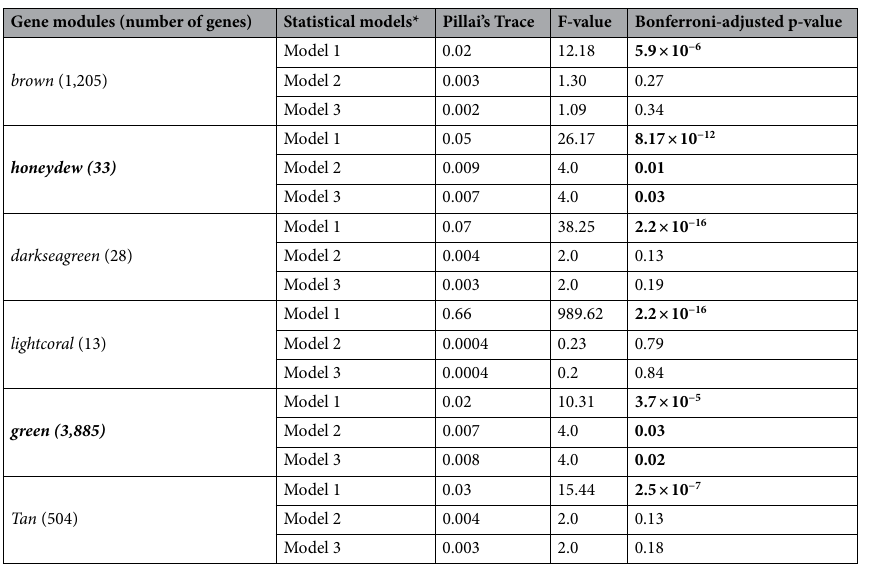
Table 3. Multivariate analysis of variance (MANOVA) test results from association analyses between the summary expression profiles of the six significant gene modules and early traits of both osteoporosis and atherosclerosis, using three differently adjusted models (1–3), as described in the table footnote*. The most significant gene modules across all the three tested models are in bold. Statistical models*: MANOVA model 1 was designed to investigate the joint association between the summary expression profiles of the gene modules and early traits of both osteoporosis and atherosclerosis with no covariates. Model 2 was adjusted with age, sex and body mass index. Model 3 was the same as model 2 but additionally adjusted for smoking, alcohol consumption and variables related to physical activity.